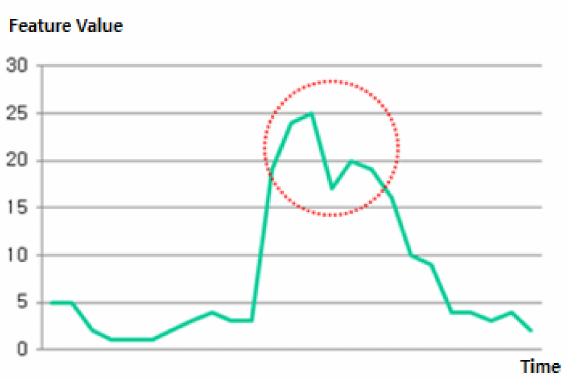
Figure 8. Example of extracted DAMV features. The circled area indicates when the subject made a